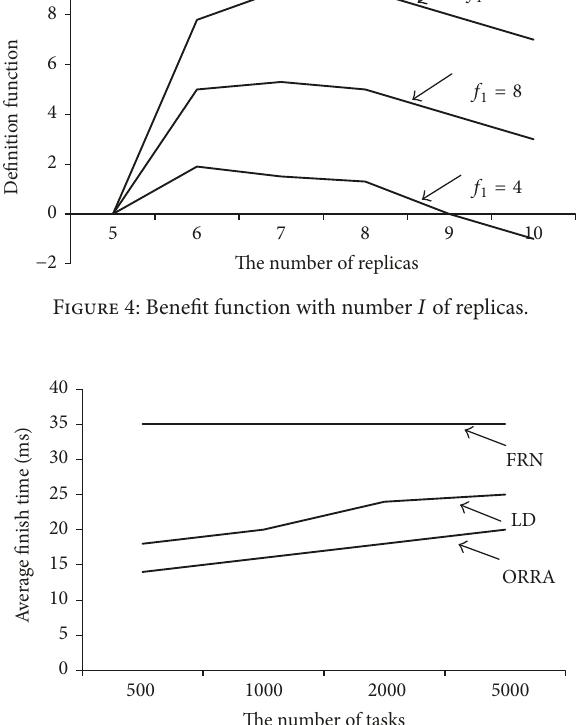
Figure 5: The comparison of average finish times for